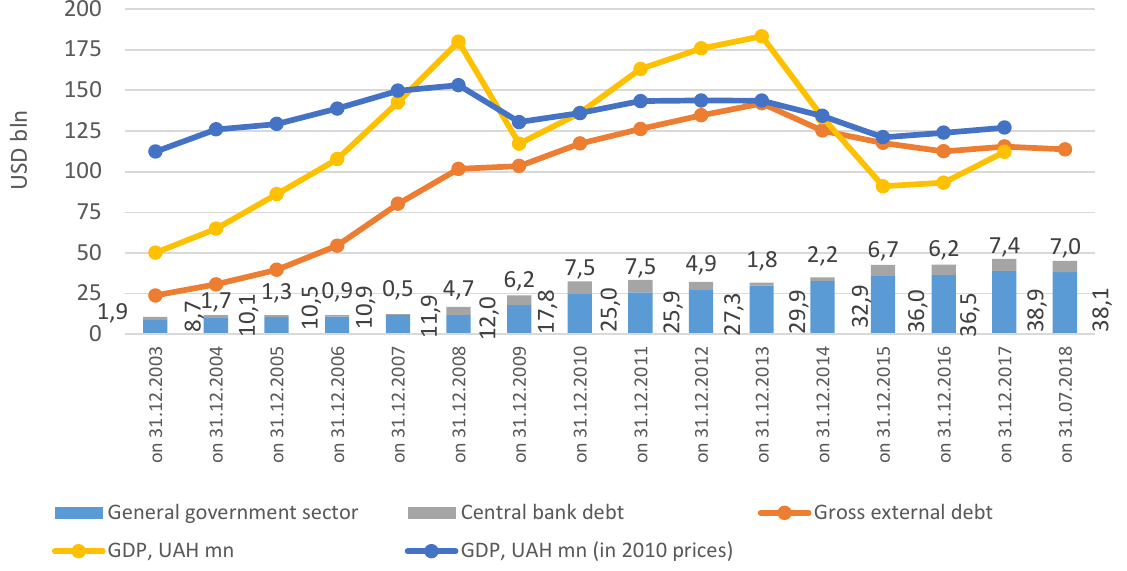
Figure 1. Dynamics of external debt and GDP of